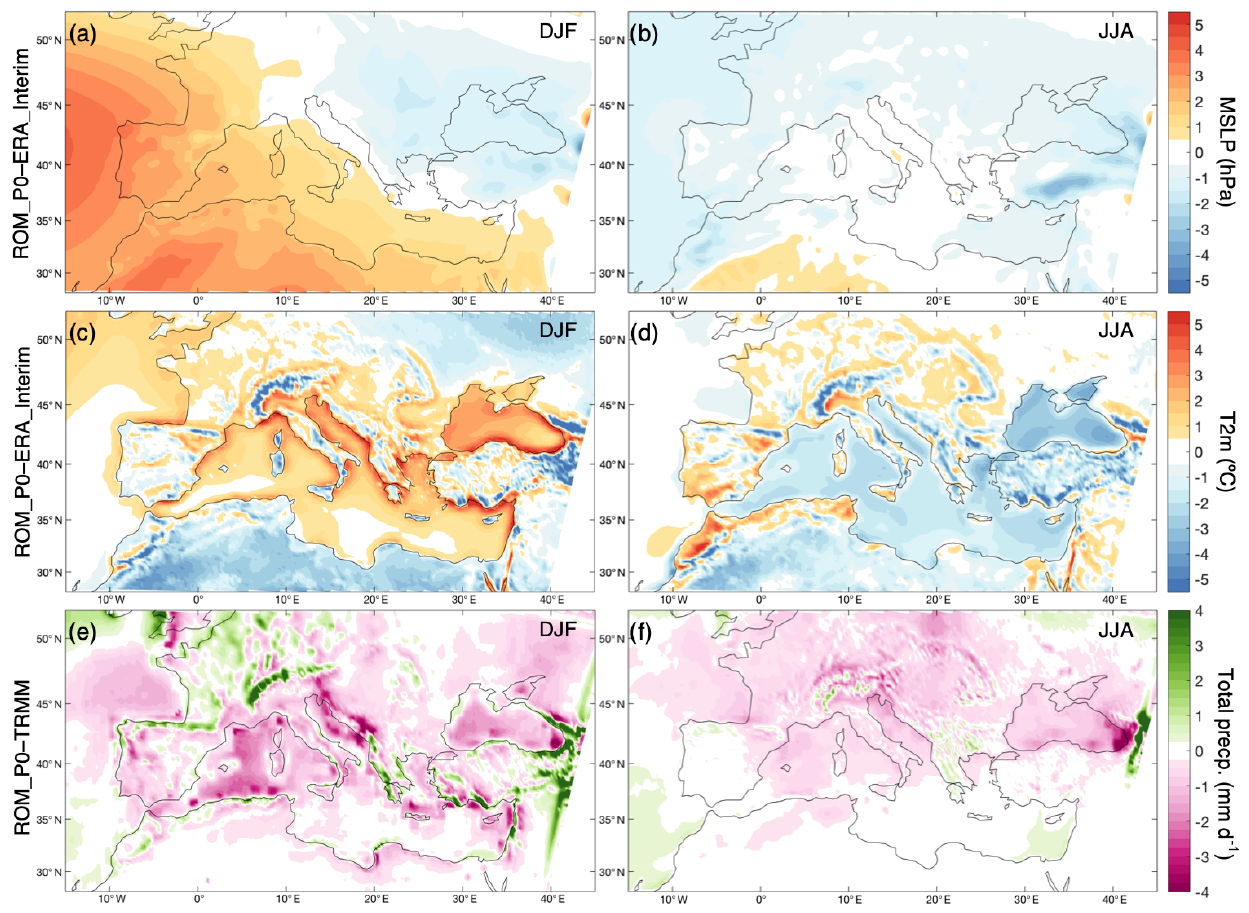
Figure 3. Differences between ROM_P0 (ERA-Interim) and TRMM for the 1980–2012 period in mean sea level pressure (MSLP, hPa) (a, b) , near-surface (2m) temperature (T2m, ◦ C) (c, d) and precipitation (mmd − 1 ) (e, f) in winter (DJF a, c, e ) and summer (JJA b, d, f